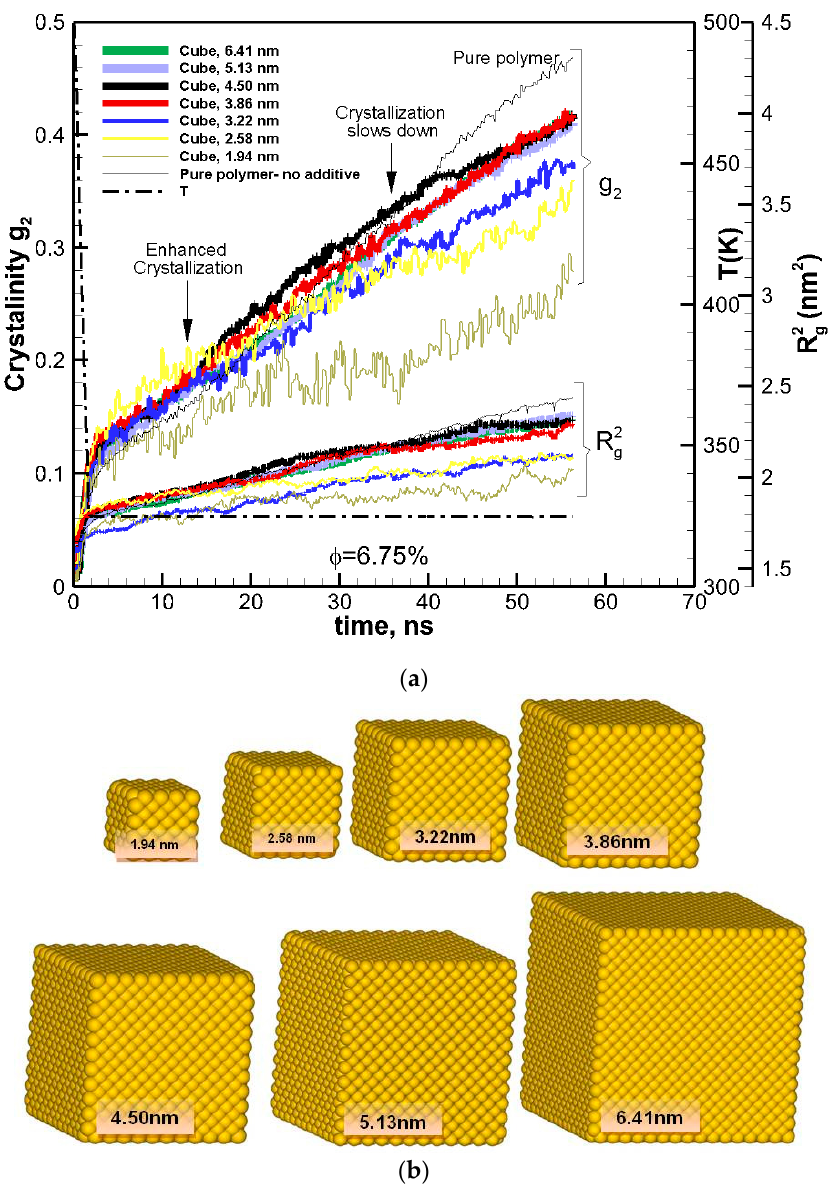
Figure 1. ( a ) Degree of crystallinity, g 2 , and square radius of gyration R 2 g shown as a function of time for pure polymer (hexacontane) (thin black solid lines) and nanocomposite polymer made of cubic gold nanoparticles of different sizes (solid lines of various thicknesses proportional to the size of additives). The volume fraction is approximately the same (~ φ = 6.75%) for all composite polymer systems. Curly brackets group the corresponding curves for g 2 and R 2 g. The arrows show two-tier crystallization regimes for nanocomposite polymers with cubic additives, where the crystallization is enhanced at the early stages and slowed down at final stages of crystallization. Temperature is shown by a dashed thick black line. ( b ) Cubic nanoparticles of various sizes used to create nanocomposite polymers. The results revealed a two-tier crystallization regime, where at the initial stages of crystallization the nanocomposite polymer systems showed enhanced crystallization in comparison to the pure polymer melt. However, as time proceeded, the rate of crystallizations slowed down for the nanocomposite systems, whereas it remained almost the same or increased for the pure polymer. After ~56 ns of crystallization, the amount of crystallinity for all nanocomposite polymers was lower than that for the pure